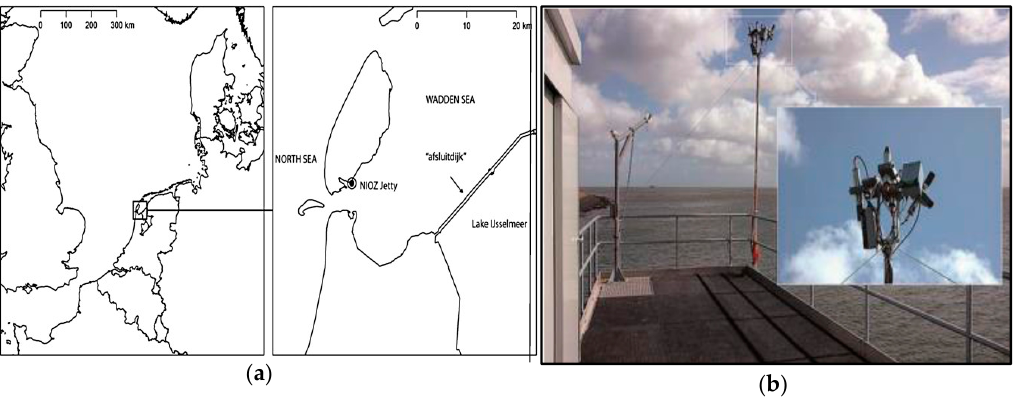
Figure 2. ( a ) The location at the NIOZ jetty sampling station in the western part of the Dutch Wadden Sea [54]; ( b ) The optical system mounted on a pole on the platform of the NIOZ jetty in the Wadden Sea [53].